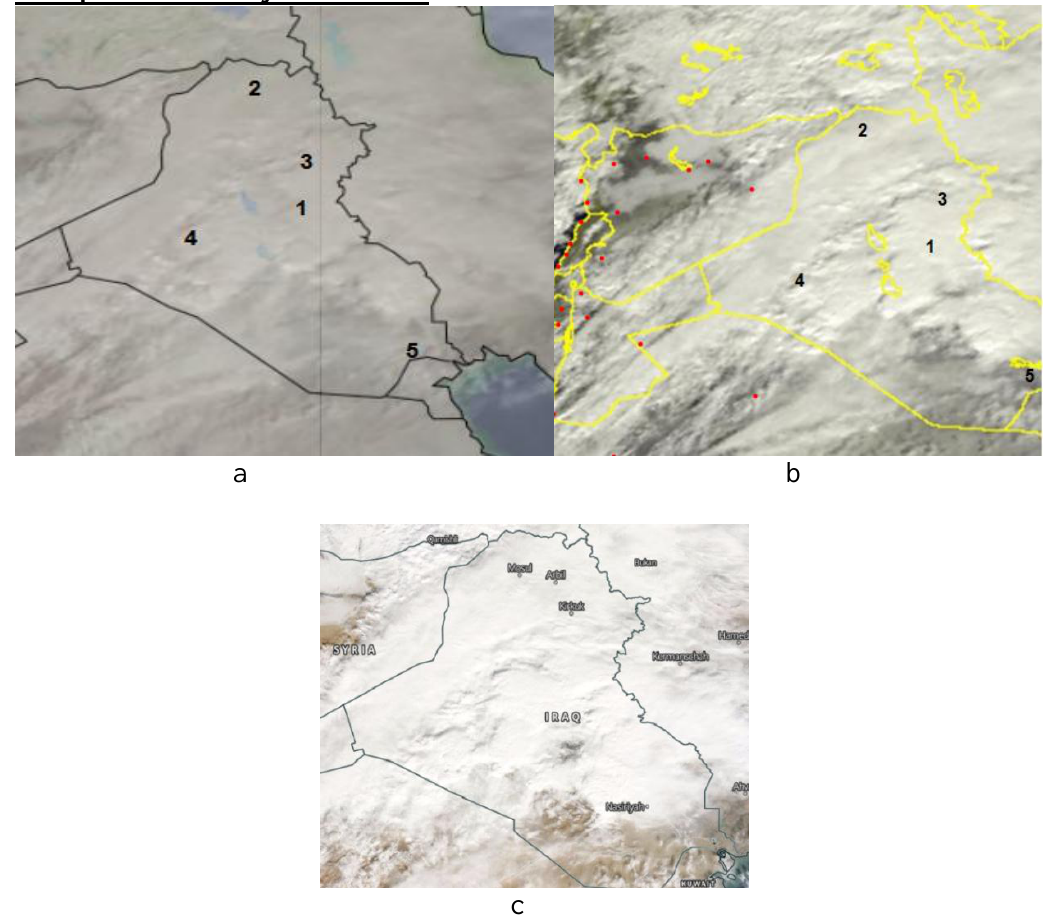
Fig. 10: a) Grayscale visible goes satellite image, b): grayscale visible METEOSAT satellite image, c): true color terra MODIS visible satellite image.